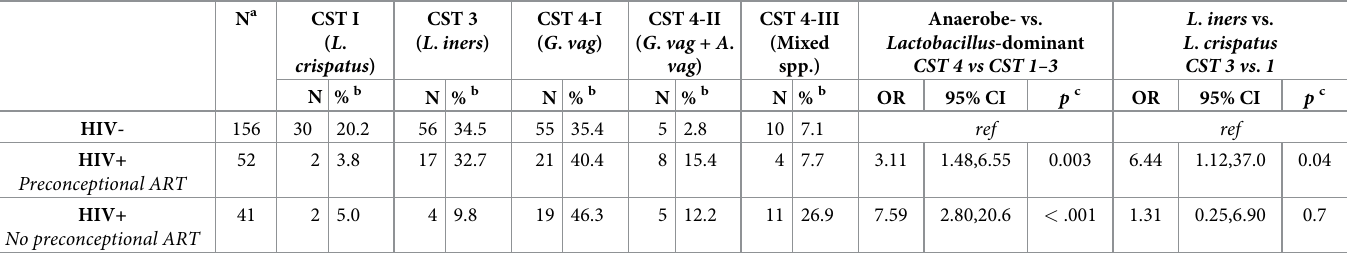
Table 3. Prevalence of community states types by HIV status and timing of antiretroviral therapy exposure, n =